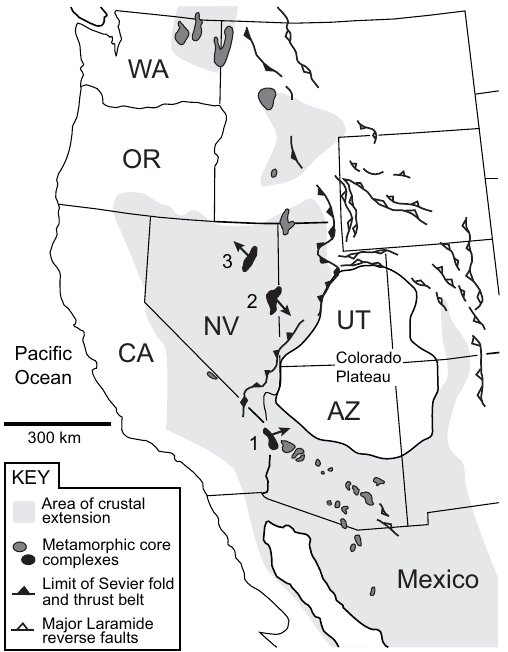
Figure 1. Simplified geological maps and cross sections of the three study areas. In each case, the mylonitic lineation is shown schematically. (a) Whipple Mountains. Map and cross section af- ter Davis and Lister (1988), Anderson and Rowley (1981), and Behr and Platt (2011). NE–SW mylonitic lineation added from Hacker et al. (1992). MF: mylonitic front. (b) Northern Snake Range. Map after Gans et al. (1999a, b), Lee et al. (1999a, b, c), Miller and Gans (1999), and Miller et al. (1999). Dashes repre- sent the WNW–ESE mylonitic stretching lineation, which disap- pears in the northwest corner of the range. Cross section modi- fied from Lee and Sutter (1991). (c) Ruby Mountains–East Hum- boldt Range. Map redrawn from Henry et al. (2011), modified from originals by McGrew and Snee (1994), Crafford (2007), and Colgan et al. (2010a). The distribution of high-stress mylonite on the maps and cross sections is schematic. In all three maps, non- mylonitic footwall = crystalline footwall rocks that lack evidence for ductile deformation during core-complex evolution, but may show evidence for earlier high-T ductile deformation. Sub-LDT high-strain zone = high-strain rocks with a high-temperature, low- stress, non-coaxial microstructure that formed part of a zone of distributed deformation below the LDT. High-stress footwall my- lonite = mylonitic rocks with a low-temperature, high-stress, non- coaxial microstructure localized beneath the